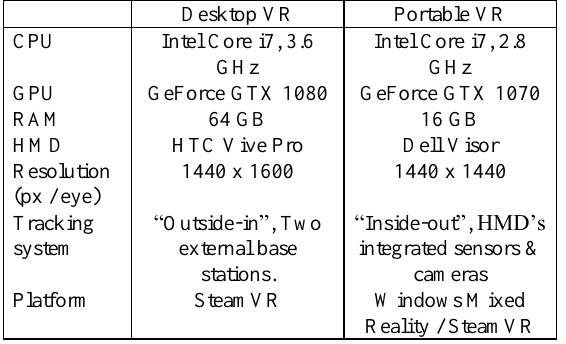
Table 3. Tested VR systems.